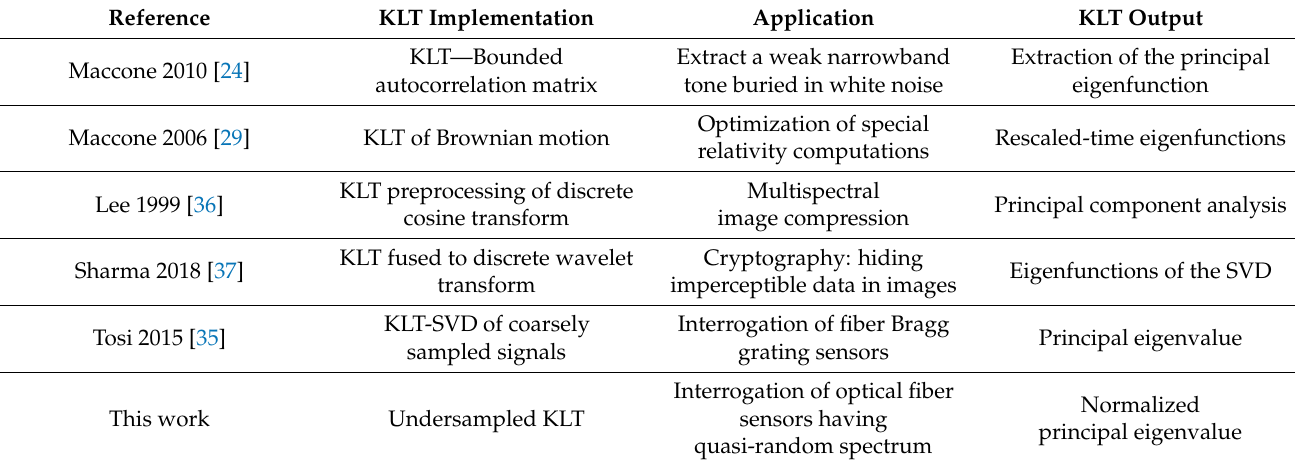
Table 1. Review of some recent implementations of KLT in signal processing related to sensing data and analysis, and practical